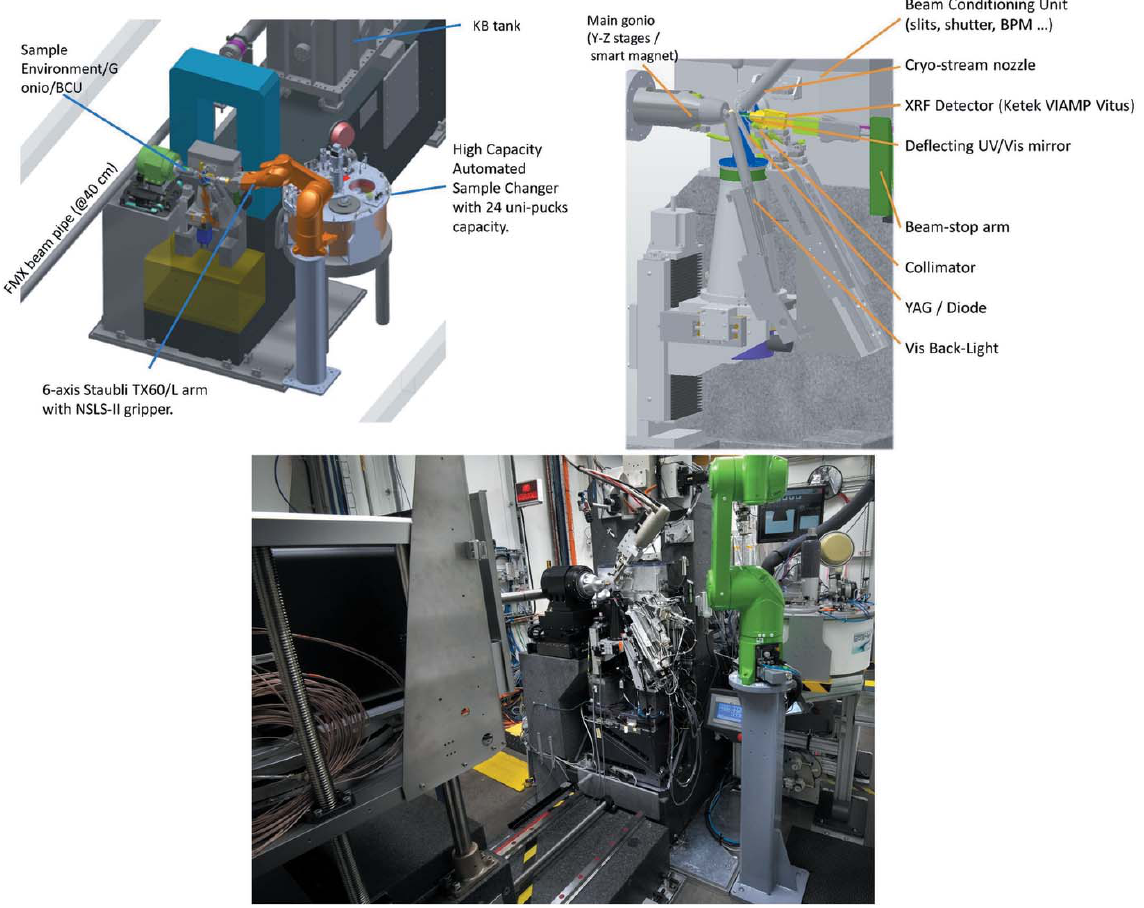
Figure 4 AMX endstation. Top left: design of the sample environment including most devices. Top-right: design of the end-station showing the main components. Bottom: photograph of the AMX endstation with the Eiger X 9M on the left and the six-axis TX60L arm/24-unipucks dewar on the